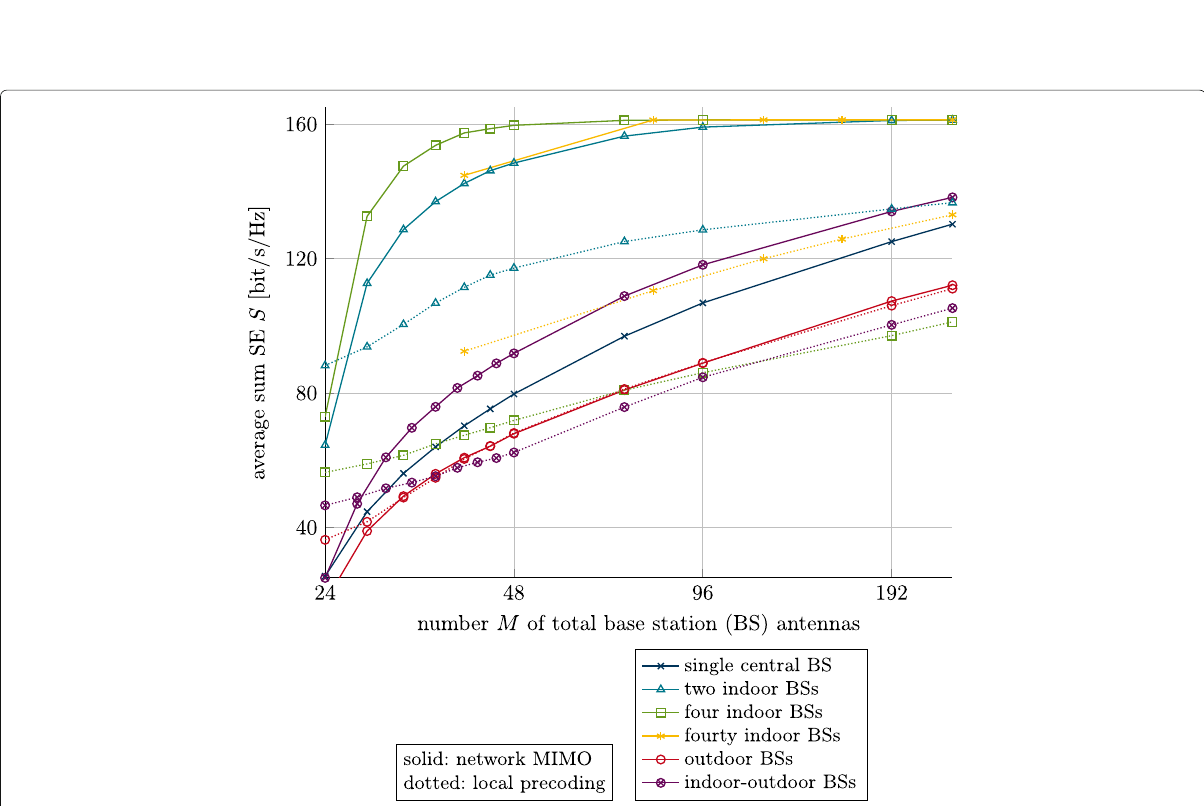
Fig. 3 Network MIMO versus local precoding. Average sum SEs with network MIMO and local precoding for 256 QAM and